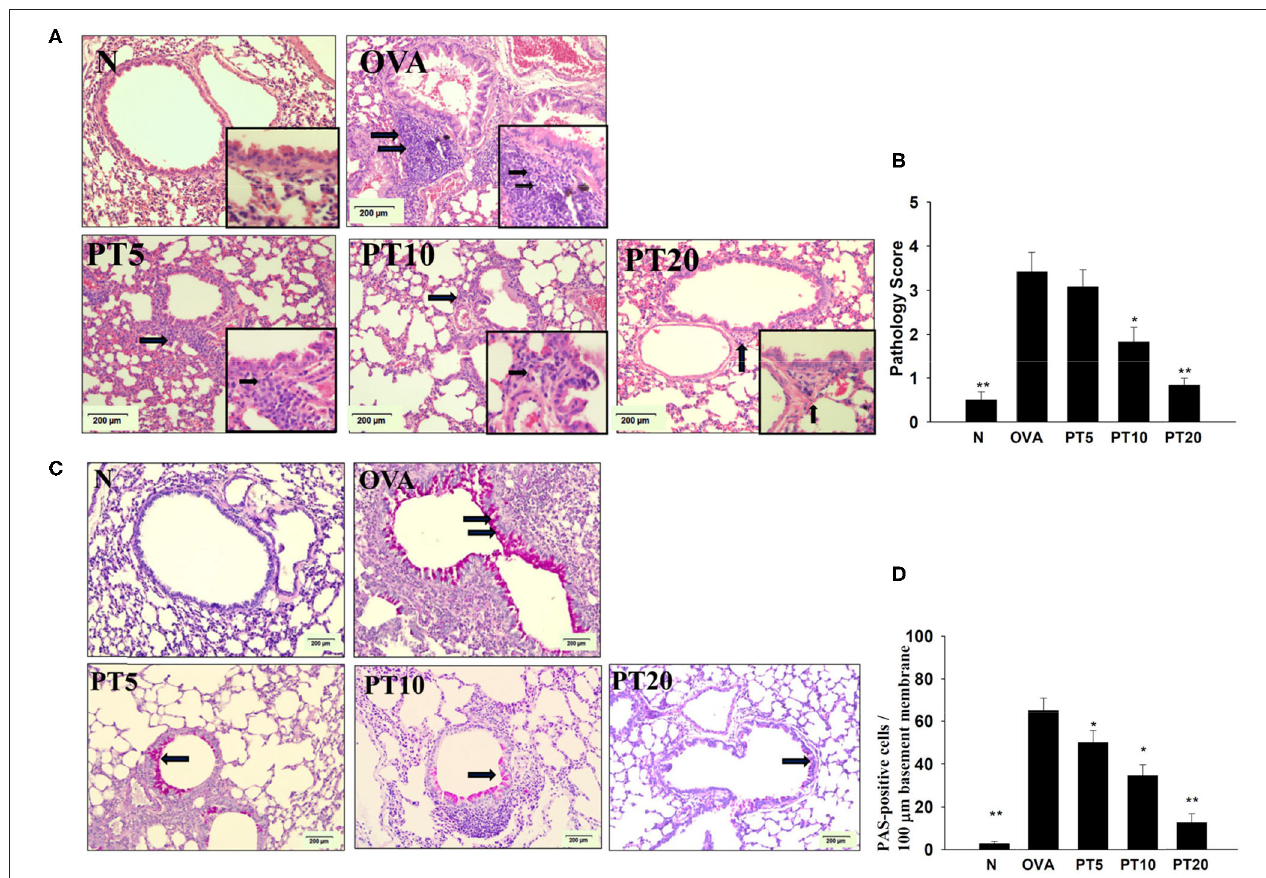
FIGURE 4 | Phloretin (PT) effects on asthmatic lung tissue . Histological sections of lung tissues from normal (N) and OVA-stimulated (OVA) mice, without or with PT (PT5-20) treatment. (A) PT reduced eosinophil infiltration; eosinophils are indicated with arrows (hematoxylin and eosin stain; 200 × magnification). Amplification sections (400 × magnification) were shown for the indicated areas. (B) Scoring of inflammation via pathological evaluation of inflammatory cell infiltration in lung sections. (C) Periodic acid-Schiff (PAS)-stained lung sections show goblet cell hyperplasia; goblet cells are indicated with arrows (200 × magnification). (D) Results were expressed as the number of PAS-positive cells per 100 µ m of basement membrane. All data are presented as the means ± SEM. * p < 0.05 compared to the OVA control group. ** p < 0.01 compared to the OVA control group. Three independent experiments were analyzed and compared with the OVA-sensitive mice.